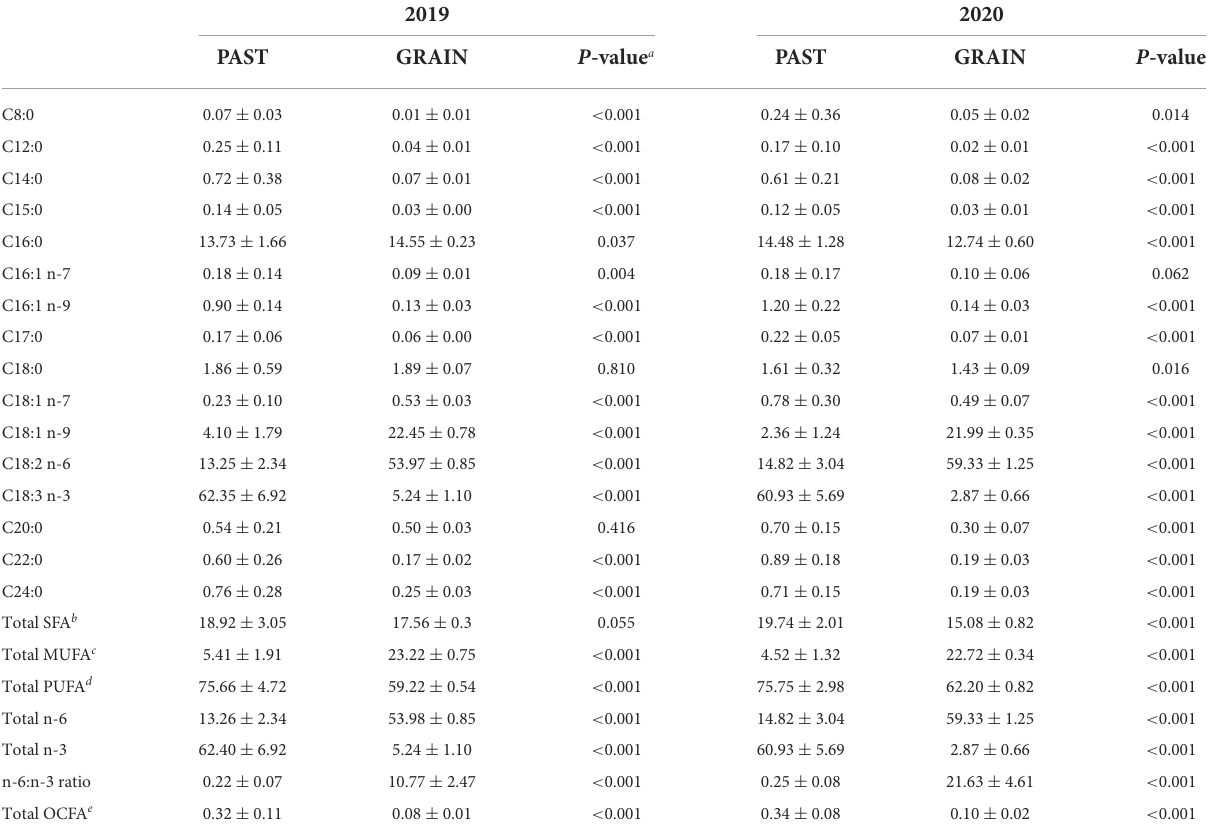
TABLE 3 Fatty acid profiles of the